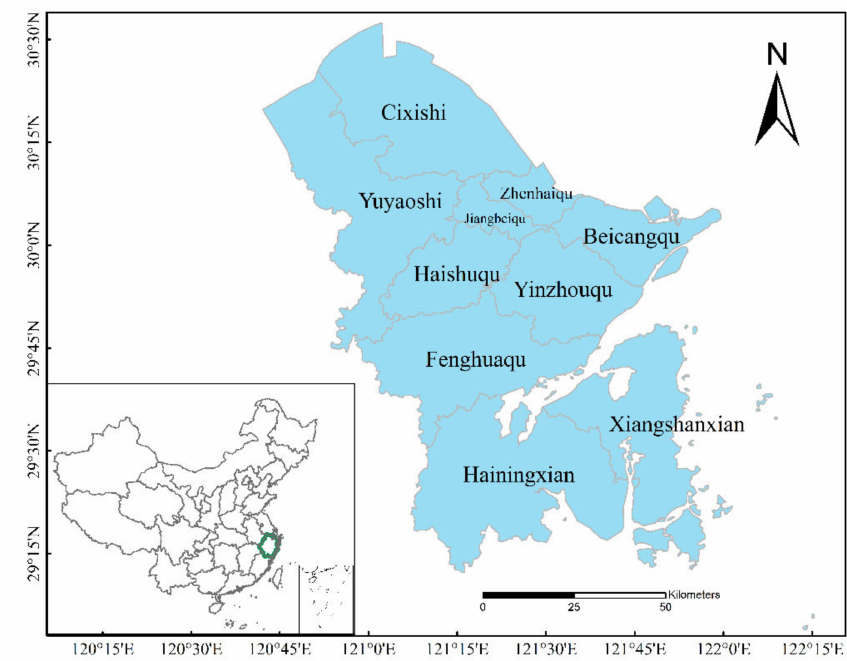
Figure 1. Geographical locations of